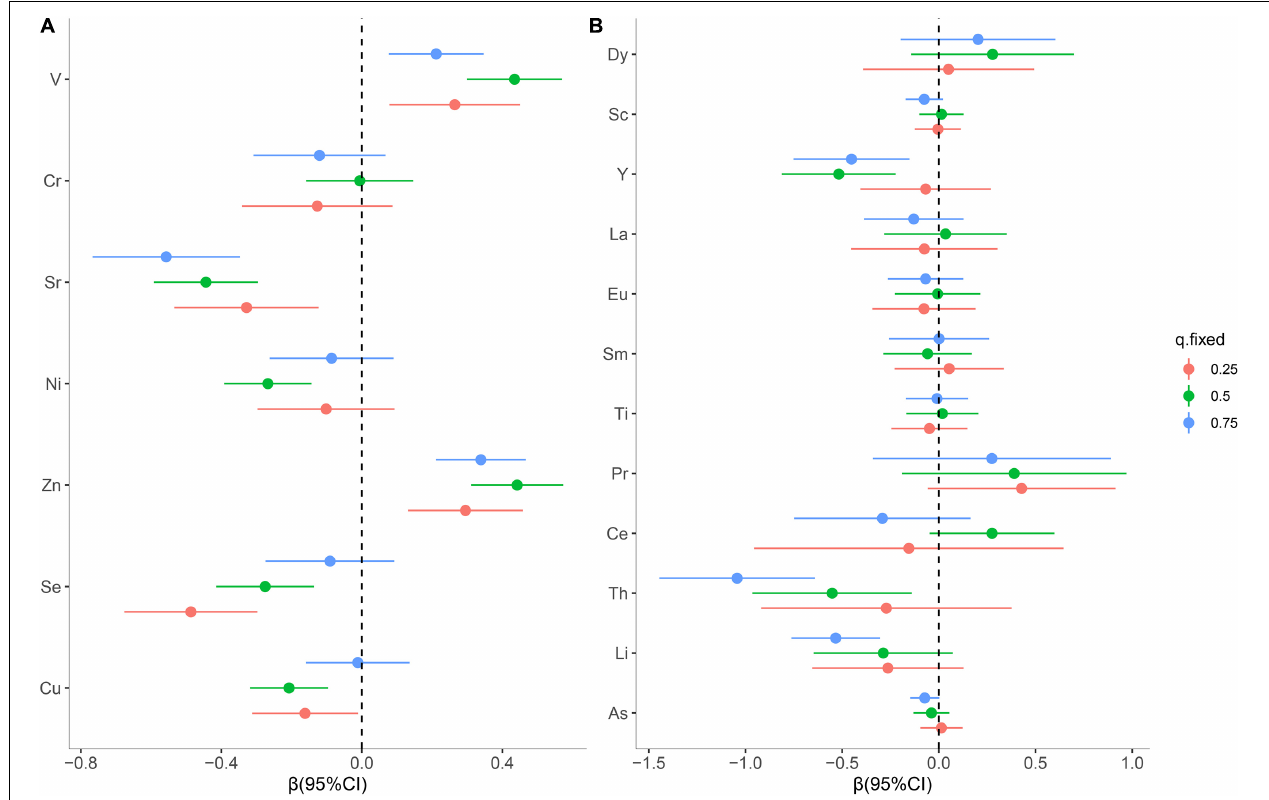
FIGURE 4 | Individual metal risk estimates (95% credible intervals) for each trace metal, while all other metals are fixed at the 25th, 50th, or 75th percentiles for essential metals (A) and non-essential metals (B)